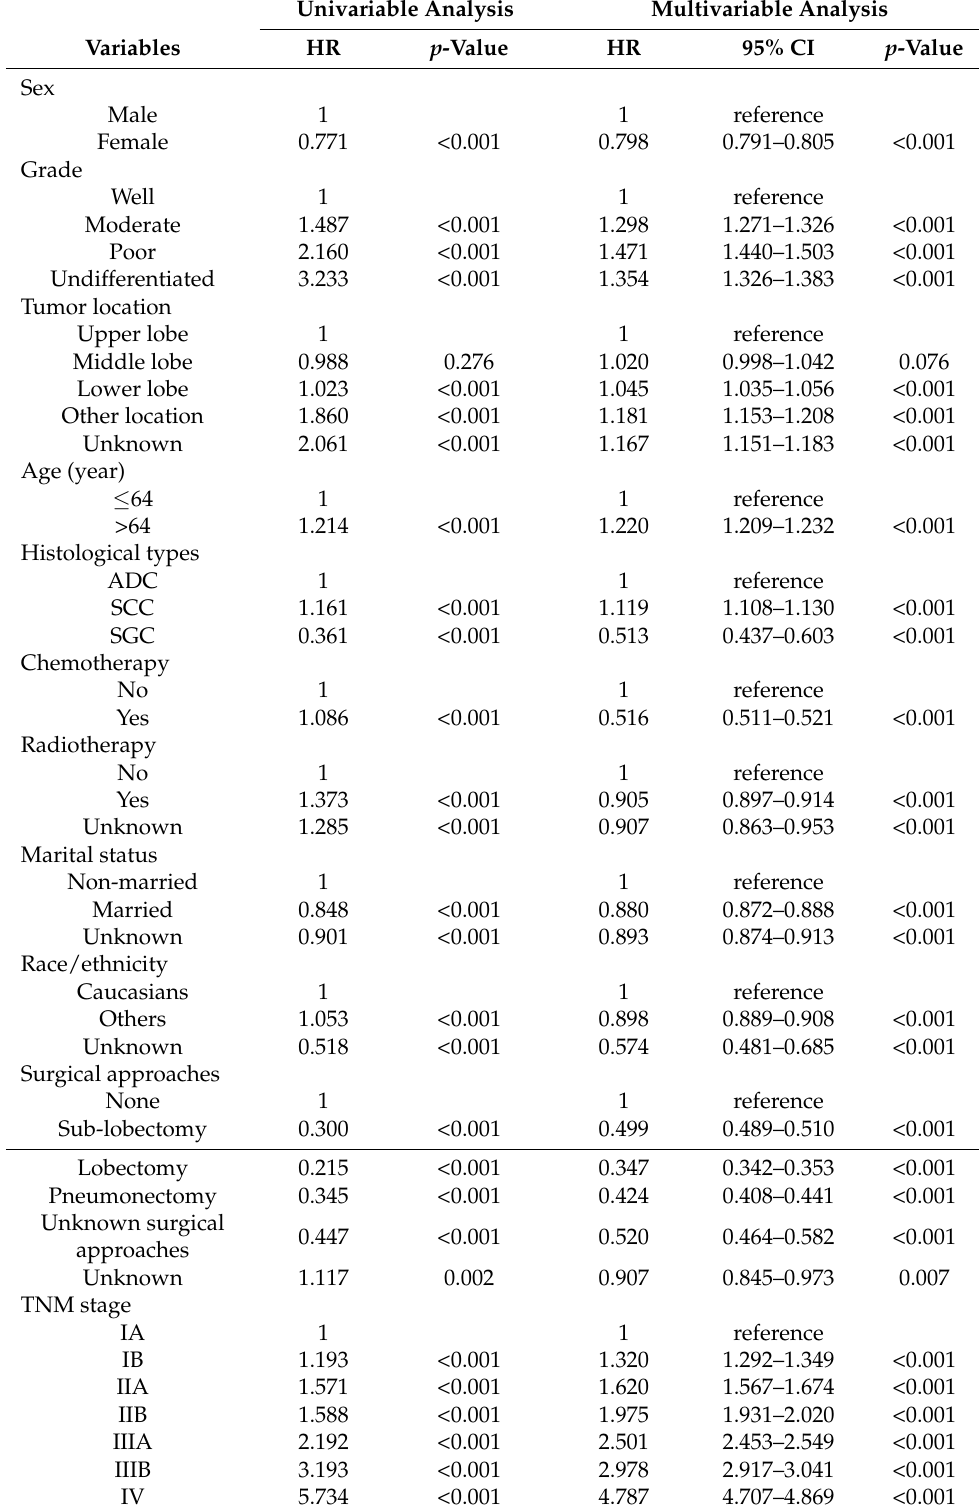
Table 3. Univariable and multivariable Cox proportional hazard regression analyses for prognostic factors in lung cancer patients with ADC, SCC, and SGC. Univariable Analysis Multivariable